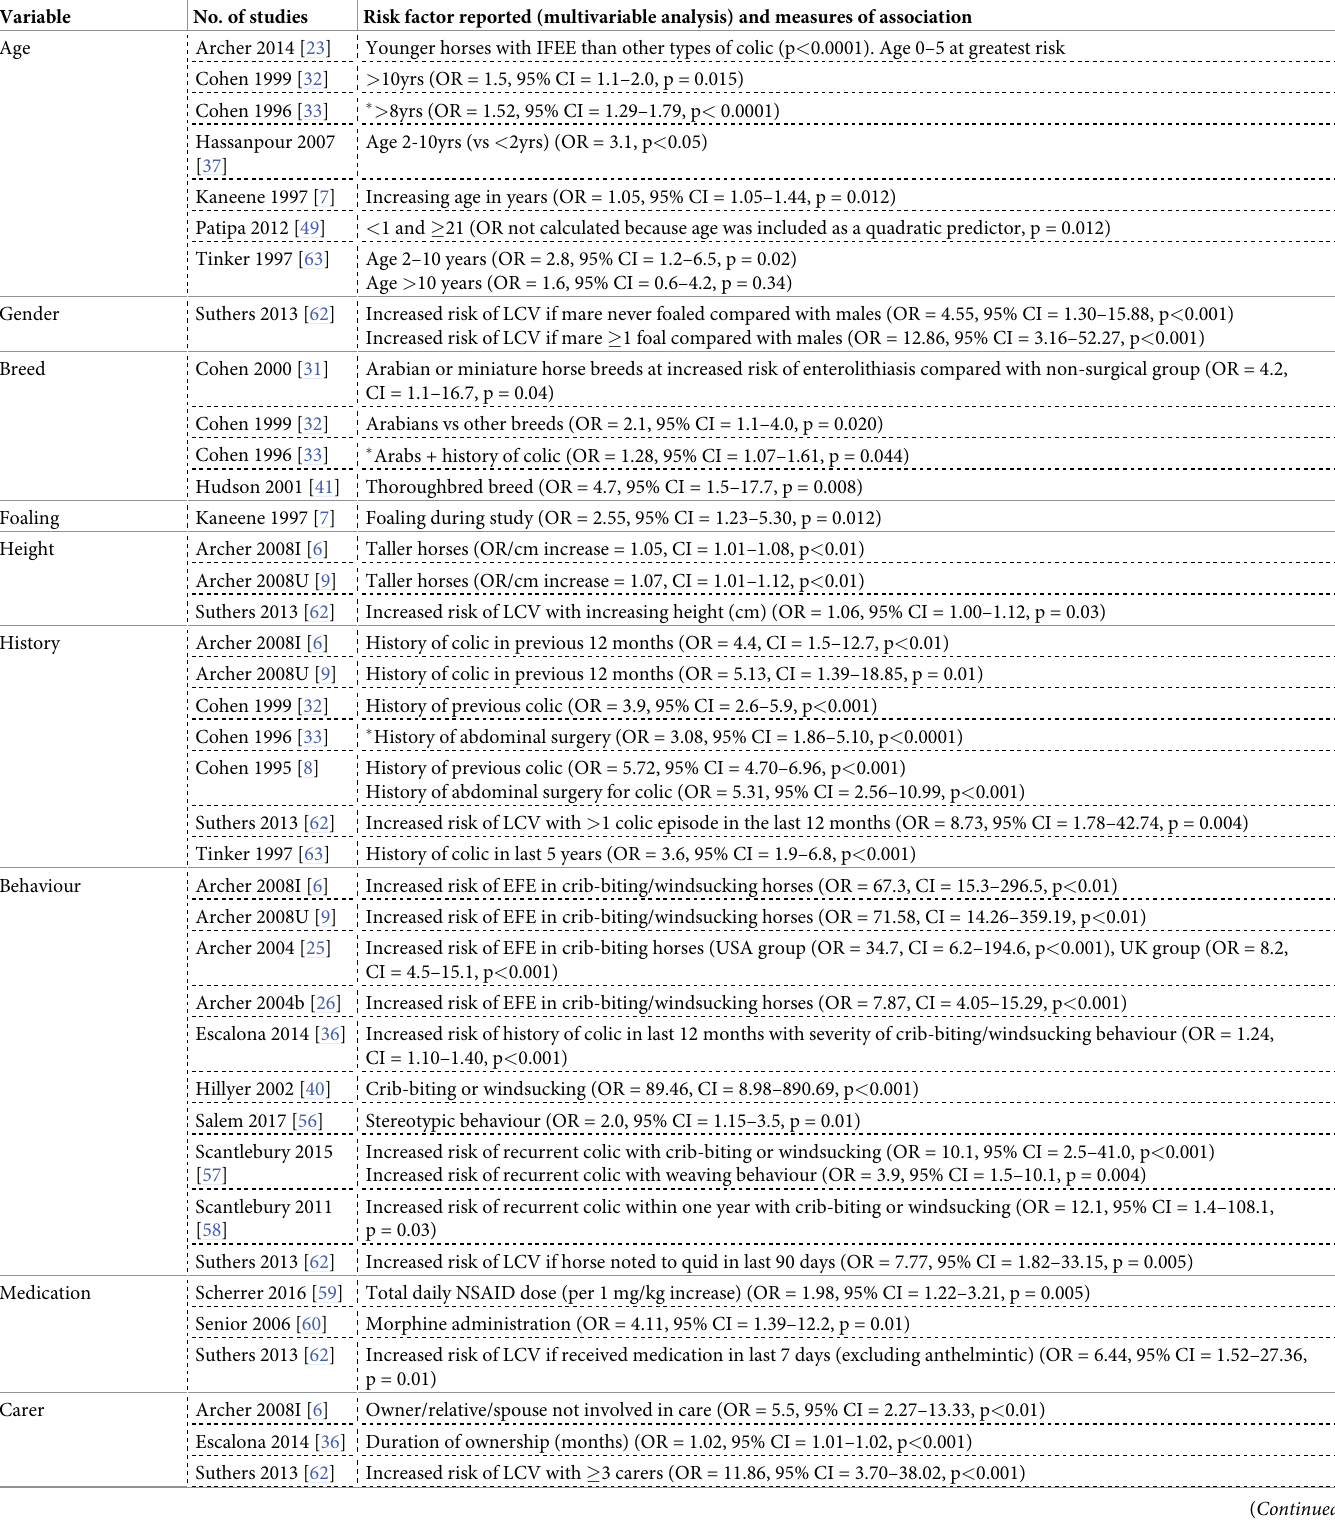
Table 4. Key findings of included publications from the scoping review which reported factors showing an increased risk of developing colic.